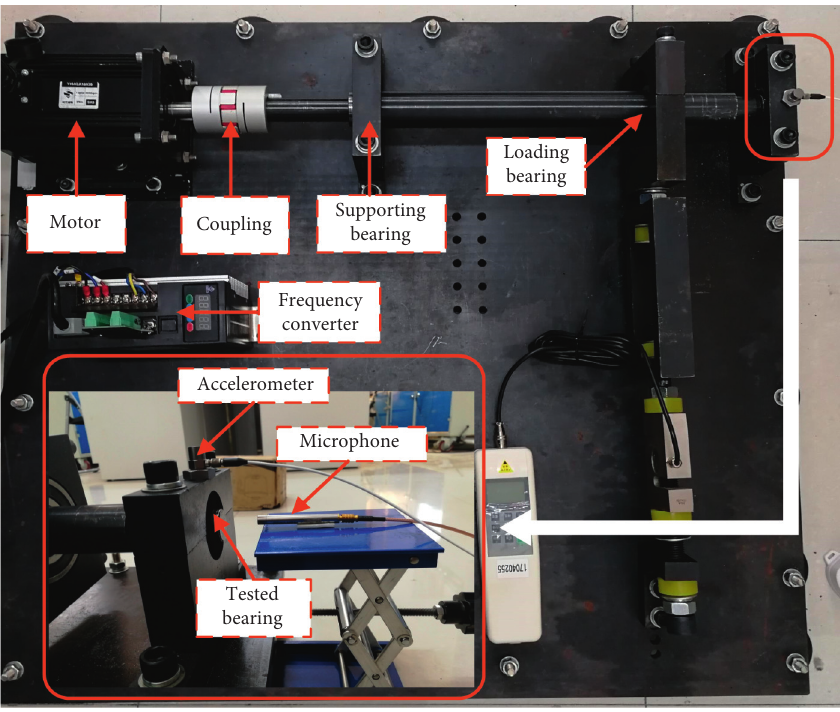
Figure 12: The entity diagram of the ID-25/30 test bench.